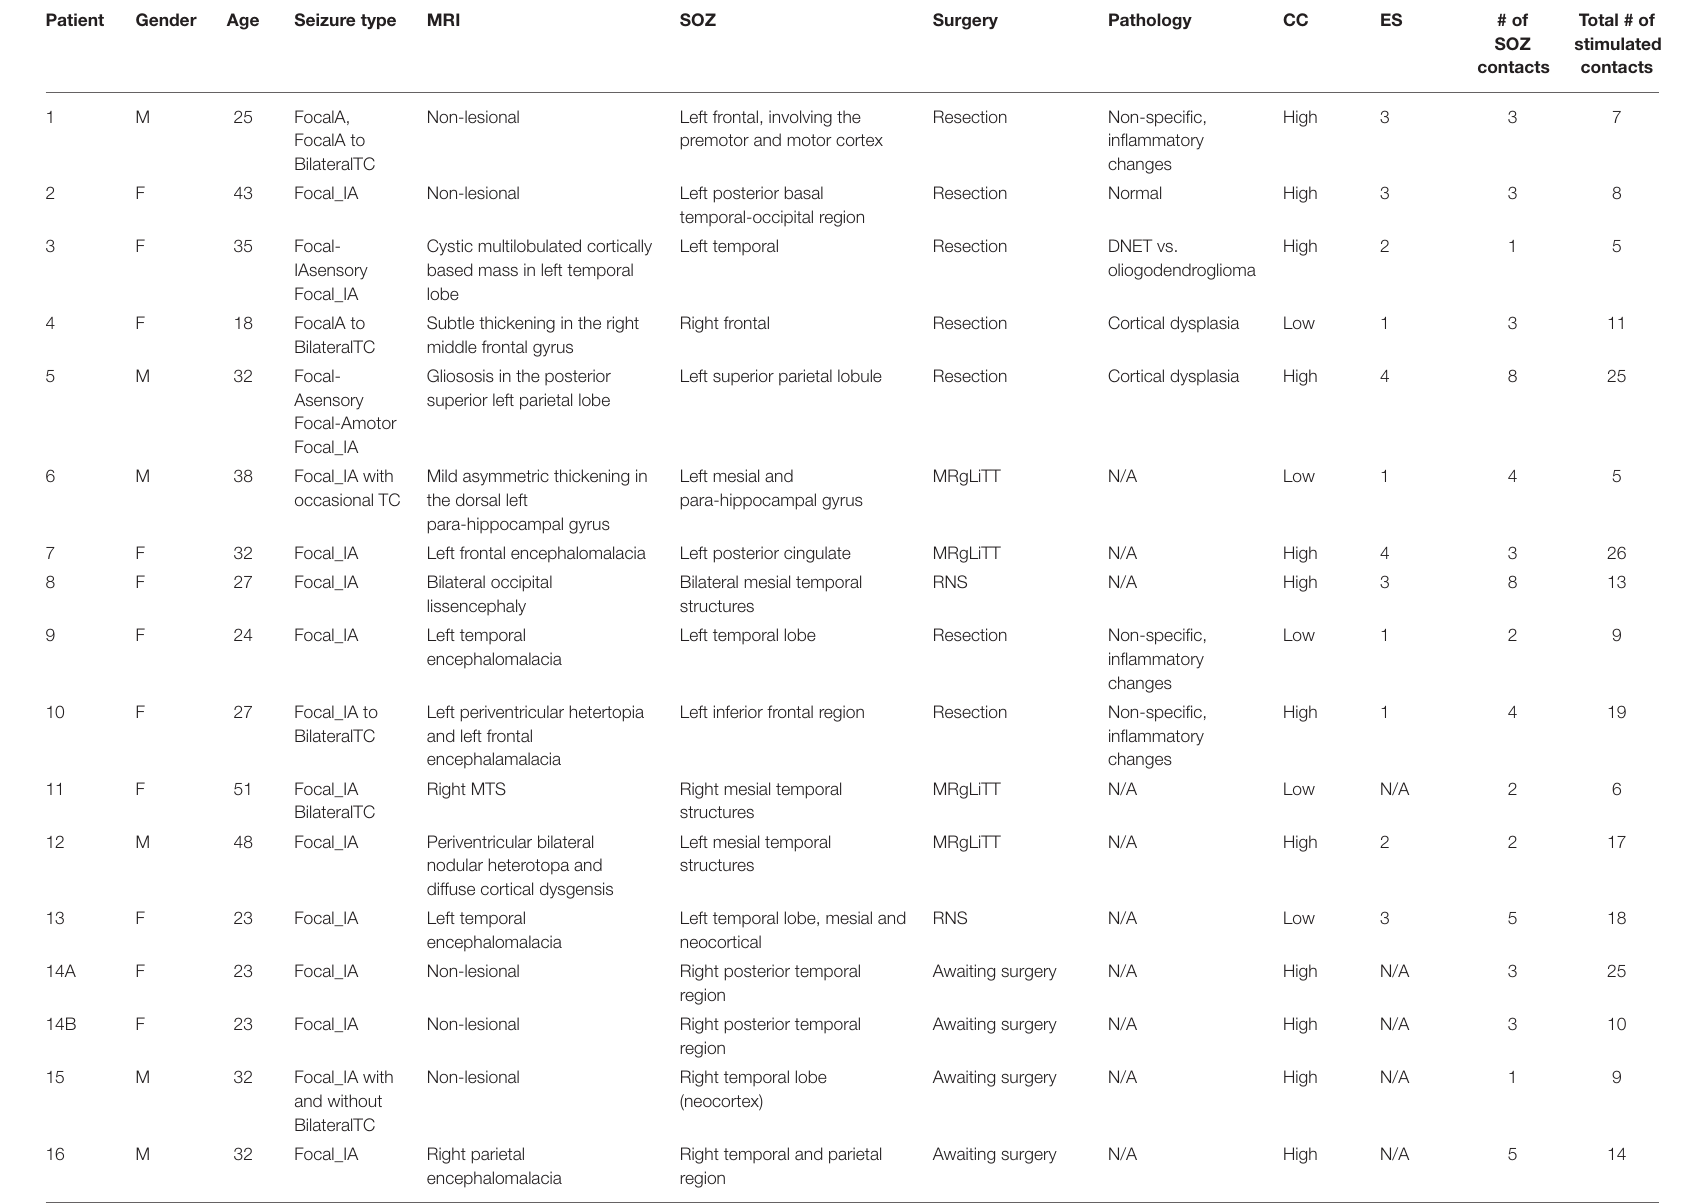
TABLE 1 | Summary of patient clinical data.